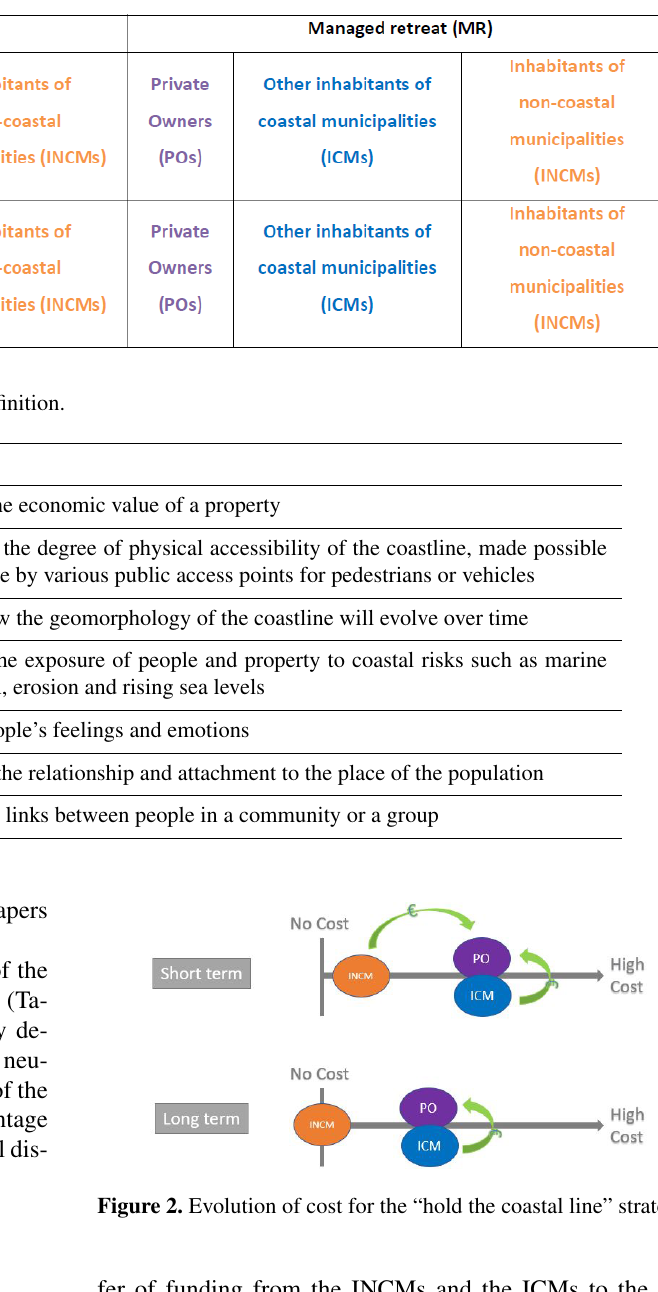
fer of funding from the INCMs and the ICMs to the POs whose property is protected by the coastal defense (Fig.